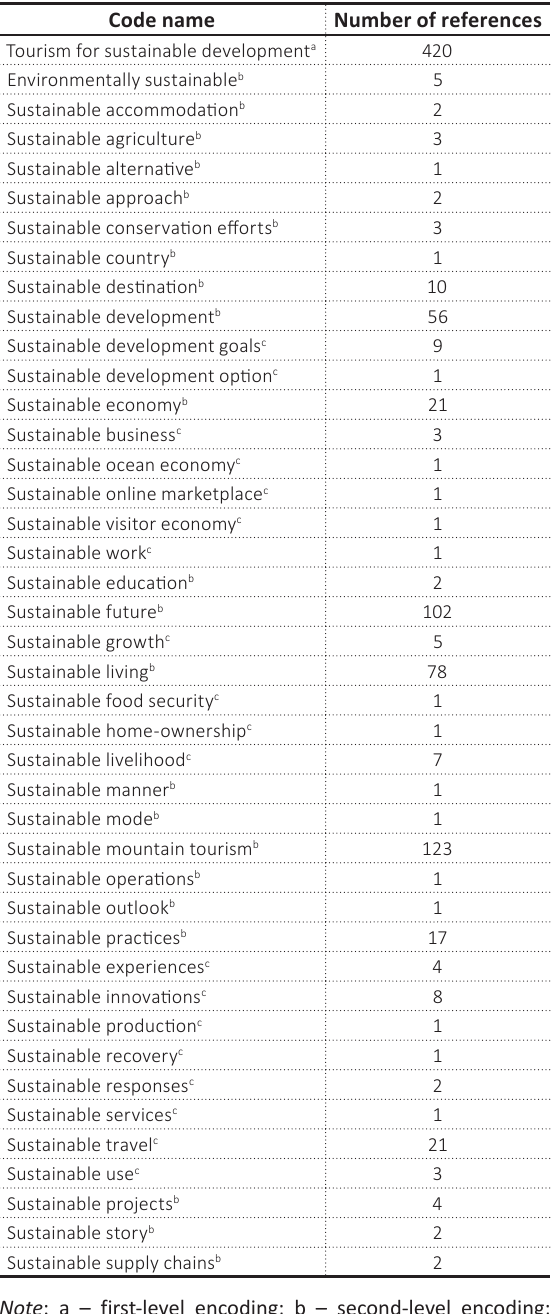
Table 2. The coding process of